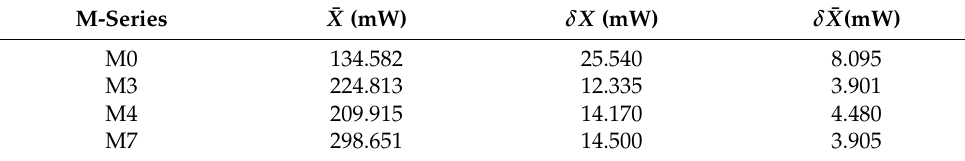
Table 2. Elliptic Curve Digital Signature Algorithm (ECDSA) power consumption.